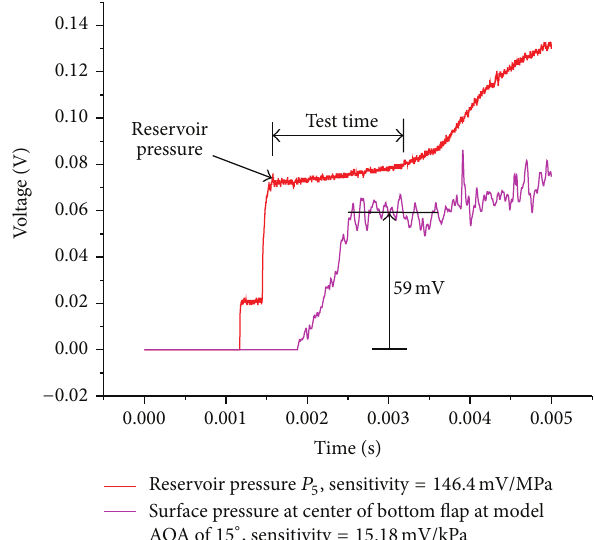
Figure 8: Typical pressure traces obtained during a test in shock